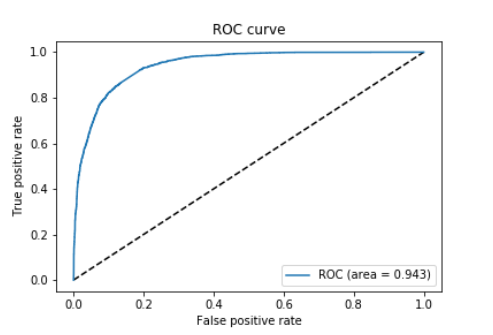
Figure 3. Receiver operating characteristic (ROC) curve on the test set for binary